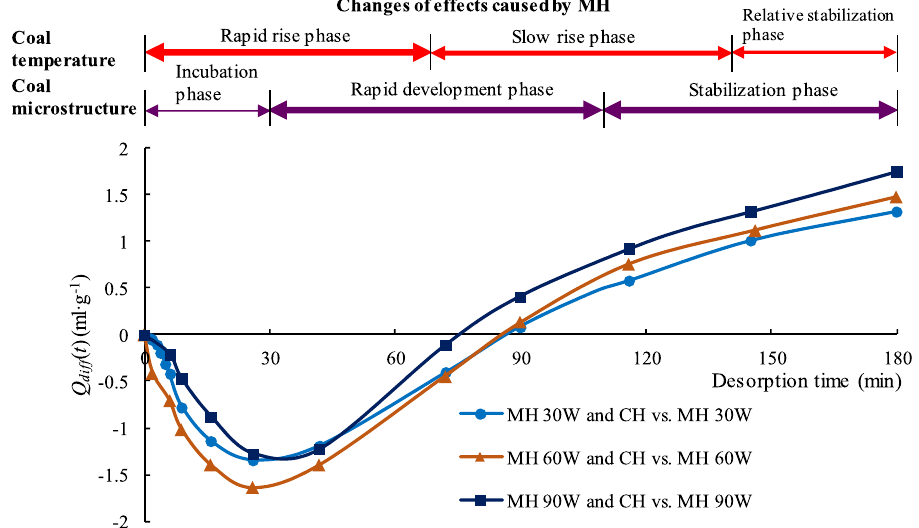
Figure 14. Graph showing the difference between MH CDV and CH CDV vs. desorption time. The widths of the horizontal lines above the graph are proportional to the intensity of the